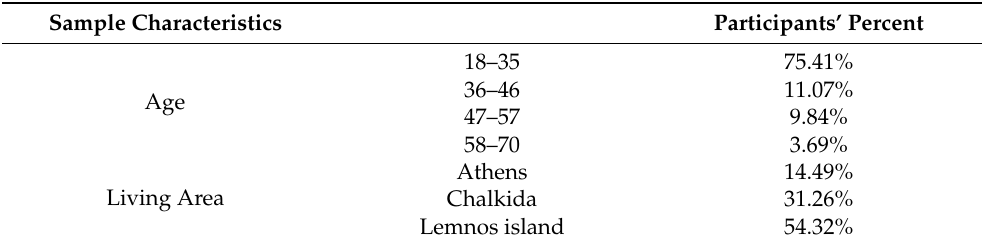
Table 1. General socio-demographic characteristics of the participants.